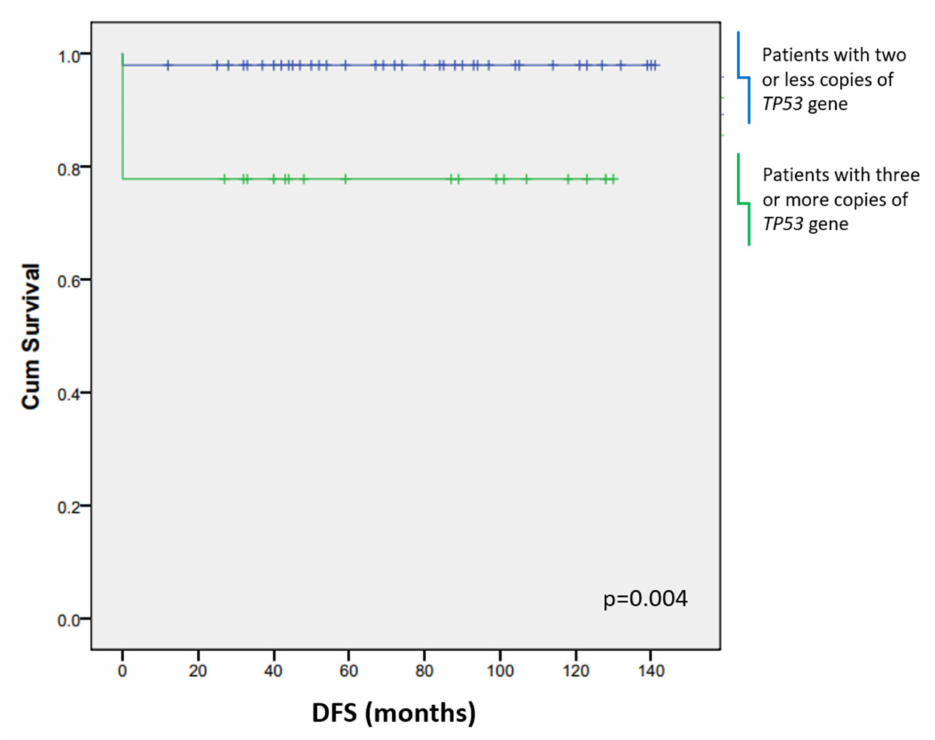
Figure 7. Poorer disease-free survival (DFS) was observed in patients who had three or more copies of the TP53 gene. Blue line: patients with two or less copies of the TP53 gene; green line: patients with three or more copies of the TP53